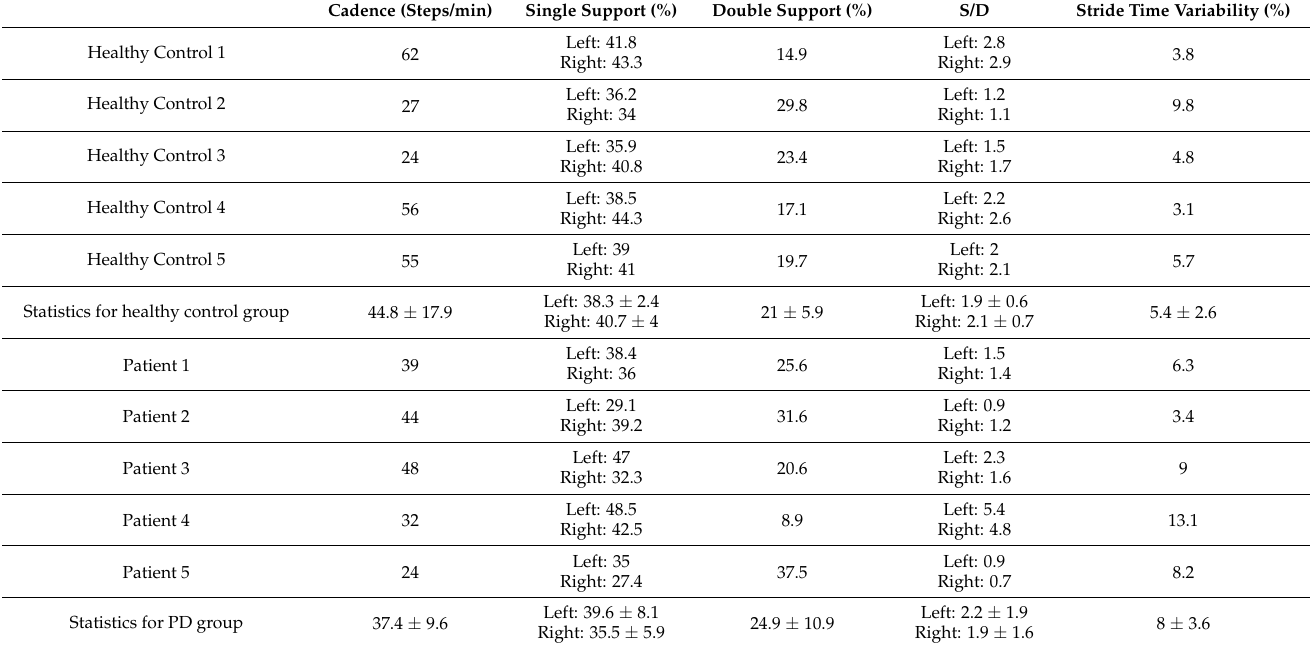
Table 3. Temporal parameters of the test